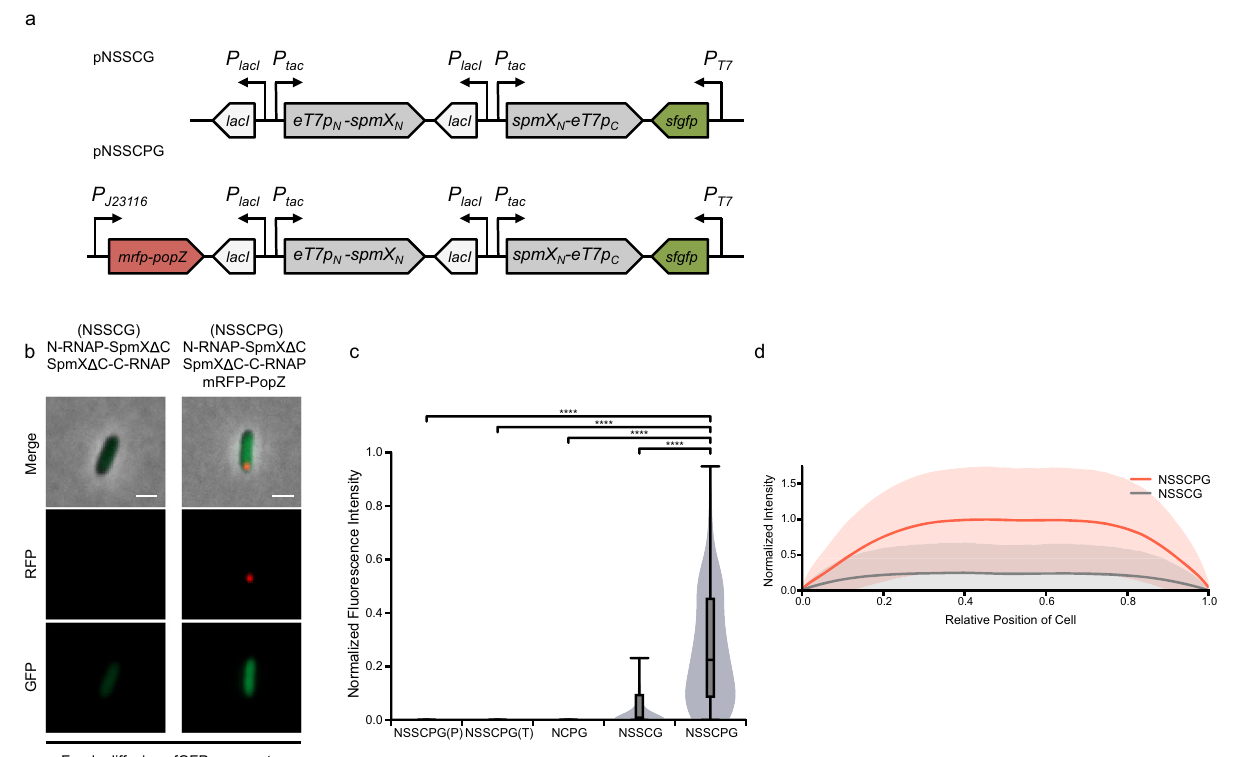
Fig. 3 Distribution of freely diffusing reporter remains symmetric. a Circuit diagram for asymmetric gene expression when freely diffusing sfGFP was used as a reporter. pNSSCPG and pNSSCG denote plasmids containing SpmX Δ C-fused RNAP halves expressed with or without mRFP-PopZ, respectively. eT7p N -spmX N denotes the SpmX Δ C-fused PACE-evolved RNAP-N; spmX N -eT7p C denotes the SpmX Δ C-fused PACE-evolved RNAP-C. Both SpmX Δ C-fused T7 RNAP halves were expressed from the IPTG-inducible promoter, P tac . sfgfp is the reporter gene under the expression of T7 promoter. mrfp-popZ gene was expressed from the Anderson promoter J23116. b Asymmetric gene expression when freely diffusing sfGFP was used as the reporter. NSSCPG and NSSCG denote SpmX Δ C-fused RNAP halves expressed with or without mRFP-PopZ, respectively, with sfGFP as the reporter. LAA degradation tag was fused to the C-terminal of sfGFP to reduce background in the control circuit (no PopZ; NSSCG). SpmX Δ C-fused RNAP halves were induced from the P tac promoter with 50 μ M IPTG for 24 h. Fluorescence was signi fi cantly higher when SpmX Δ C-fused RNAP halves were co-expressed with mRFP-PopZ. Scale bars: 1 μ m. c Quanti fi cation of fl uorescence in b with three additional negative controls: a Y571S loss-of-function mutation introduced at the C-terminal fragment of T7 RNAP, indicated as NSSCPG(P) ( a ), a truncation (deletion of the 192 – 883 residues) introduced at the C-terminal fragment of T7 RNAP, indicated as NSSCPG(T) ( b ), and removal of SpmX Δ C adaptors from both T7 RNAP halves, indicated as NCPG ( c ). Representative images of a – c are shown in Supplementary Fig. 8; n = 79, 76, 84, 253, and 148 cells for NSSCPG(P), NSSCPG(T), NCPG, NSSCG, and NSSCPG, respectively. Center line, median; box limits, upper and lower quartiles; whiskers, 1.5× interquartile range (IQR). Fluorescence intensity was normalized by the upper IQR in NSSCPG. Statistical difference was determined by two-tailed Student ’ s t -test; **** denotes P < 0.0001. d Fluorescence intensity (sfGFP) pro fi les along the long axis of the cell when SpmX Δ C-fused RNAP halves were expressed alone (gray lines) or co-expressed with mRFP-PopZ (red lines); x = 0 marks the PopZ pole. Fluorescence intensity was normalized by the maximal mean intensity in NSSCPG. Solid lines indicate averages; colored belts indicate standard deviations; n = 148 and 147 cells for with and without mRFP-PopZ co-expression, respectively. Source data are provided as a Source Data fi